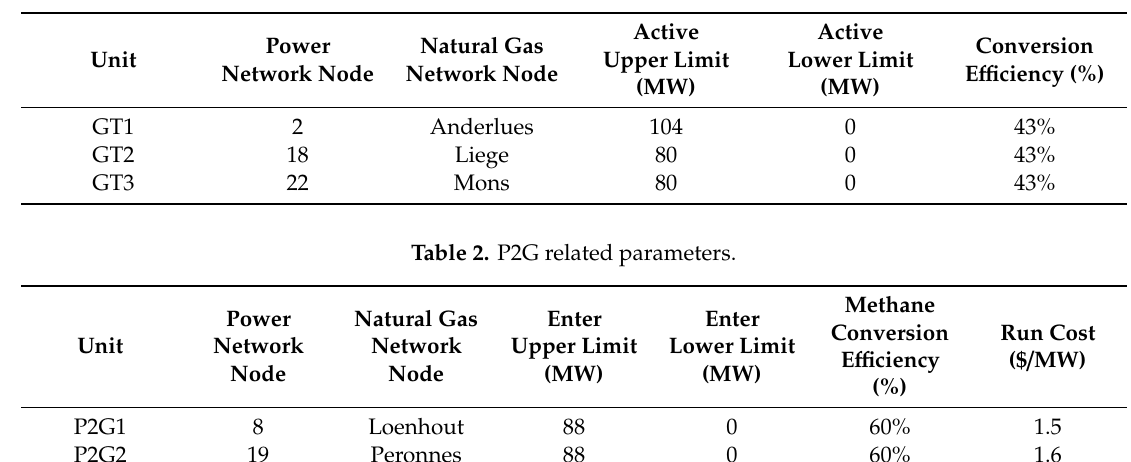
Table 2. P2G related parameters.